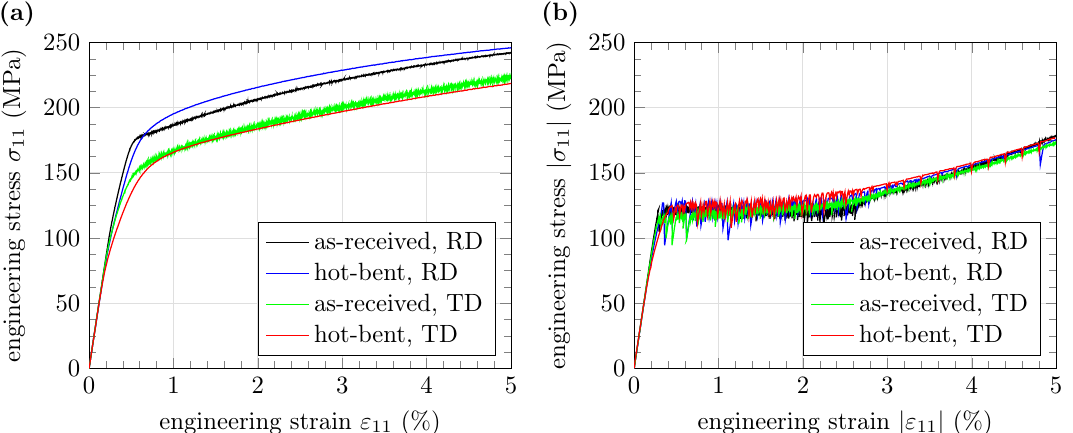
Figure 8. Engineering stress–strain curves from strain-controlled uniaxial tests with the as-received and the hot-bent material in RD and TD: ( a ) engineering stress strain curves of the uniaxial tension tests; ( b ) engineering stress strain curves of the uniaxial compression